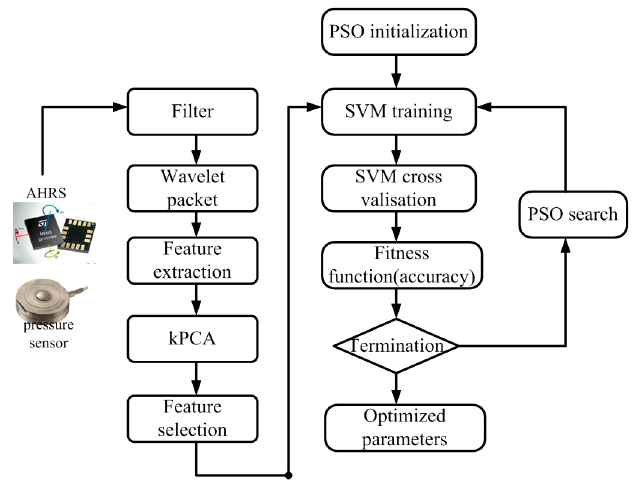
Figure11. The process of SVM optimization using PSO. Figure 11. The process of SVM optimization using